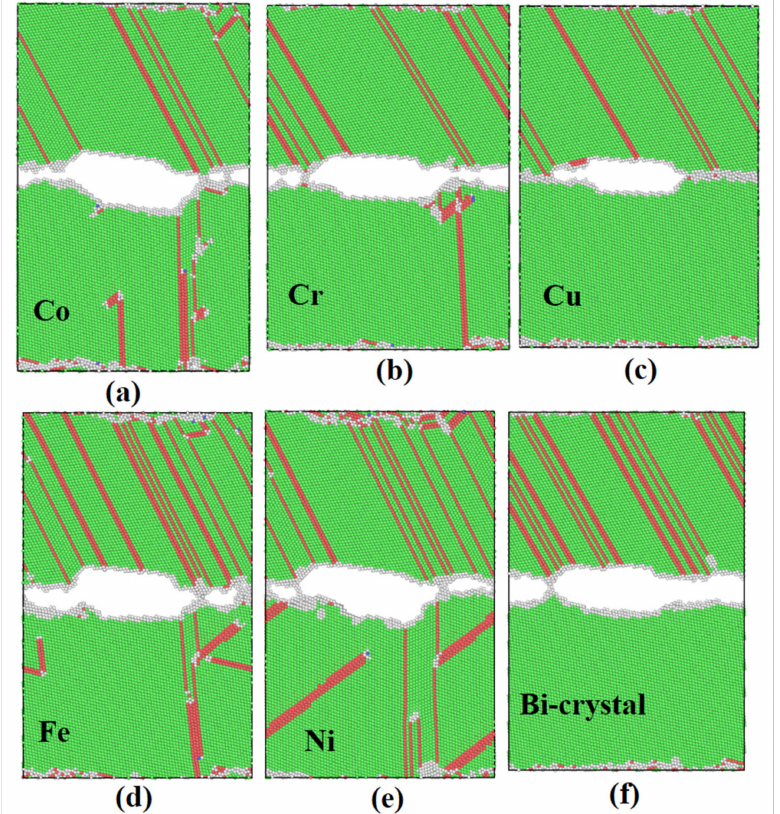
Figure 7. Bicrystals during stretching before breaking. Twins are shown in red, and atoms of the disordered structure are shown in grey. The figure shows the bicrystal with cobalt segregation ( a ), chromium segregation ( b ), copper segregation ( c ), iron segregation ( d ), and nickel segregation ( e ), and bicrystal without segregations ( f